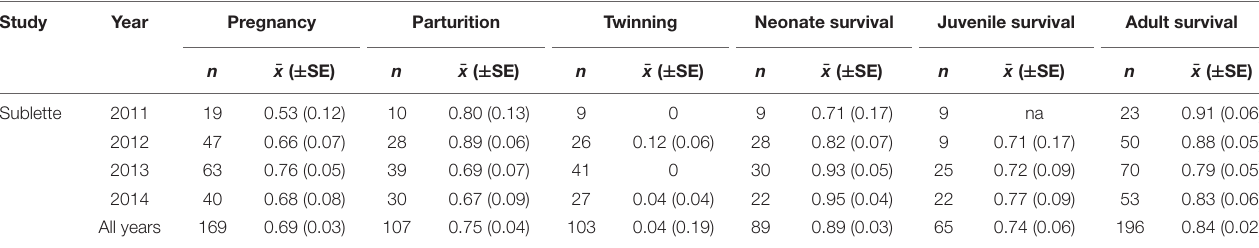
FIGURE 2 | Predicted probabilities ( ± 95% CI) and observed values of (A) pregnancy, (C,D) parturition, and (B) overwinter adult ( > 2.5 years) survival as a function of percent IFBFat for moose in Sublette 2012–2014 in western Wyoming, United States. TABLE 2 | Mean estimates (SE) and sample sizes of demographic rates from 2011 to 2014 for Sublette moose in western Wyoming, United